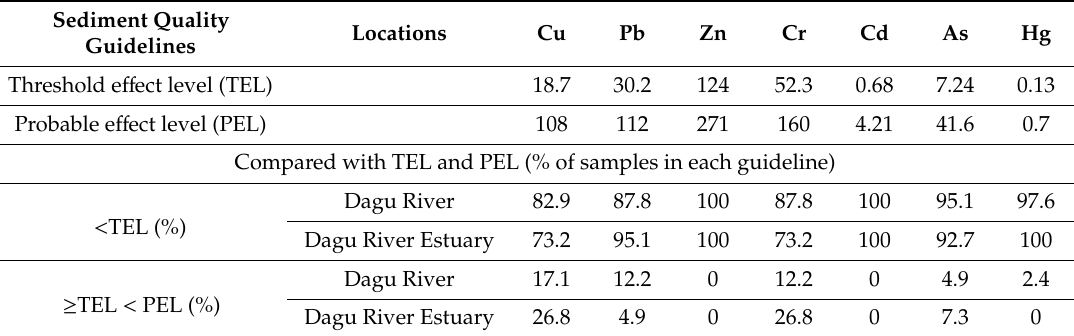
Table 2. Comparison between heavy metals and metalloids concentrations (mg / kg) in the Dagu River Estuary and sediment quality guidelines (SQGs) with percentage of samples in each